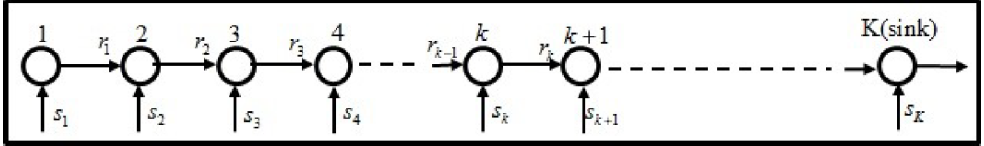
Figure 1. Chain-based network